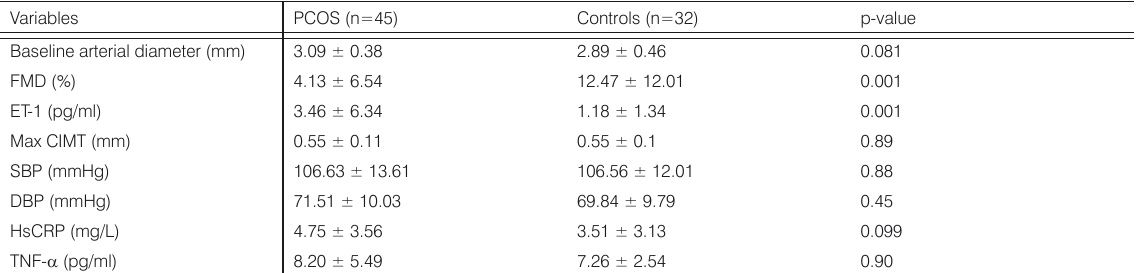
Table 2. Haemodynamic and inflammatory profile of PCOS and control women. Data are given as mean ± SE. P<0.05 was considered statistically